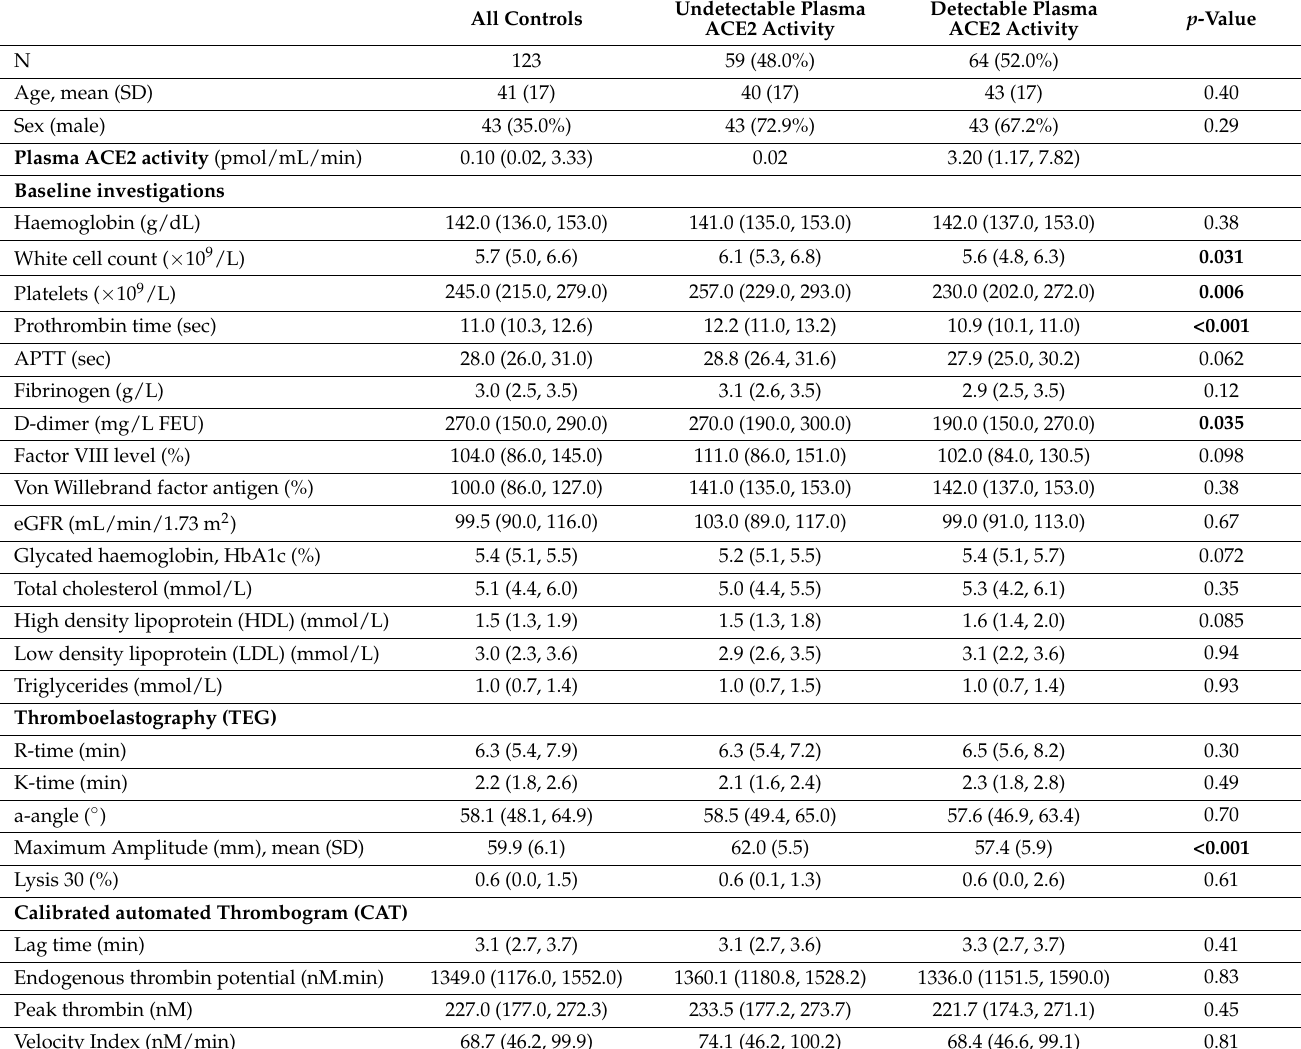
Table 1. Plasma ACE2 activity levels in healthy controls, categorized as undetectable and detectable